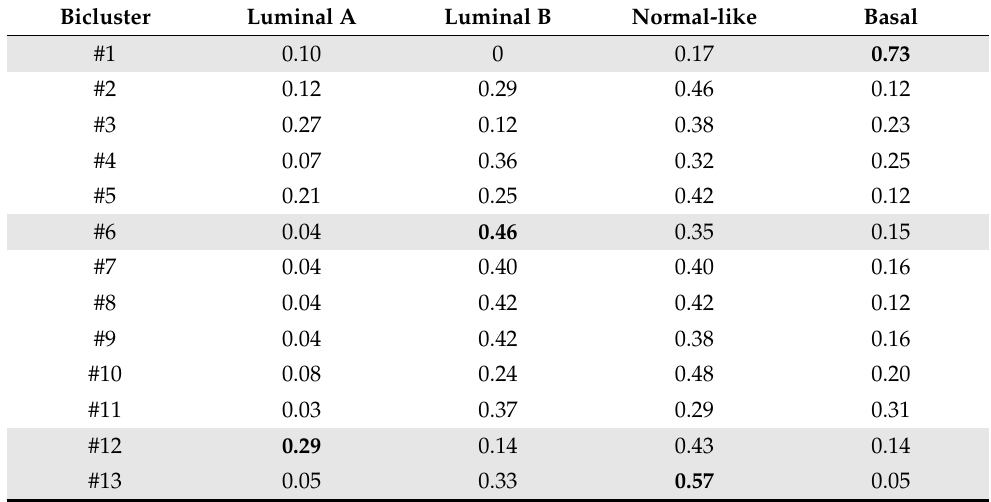
Table 1. ISA biclusters with PAM50 molecular subtypes. Top biclusters highlighted in each